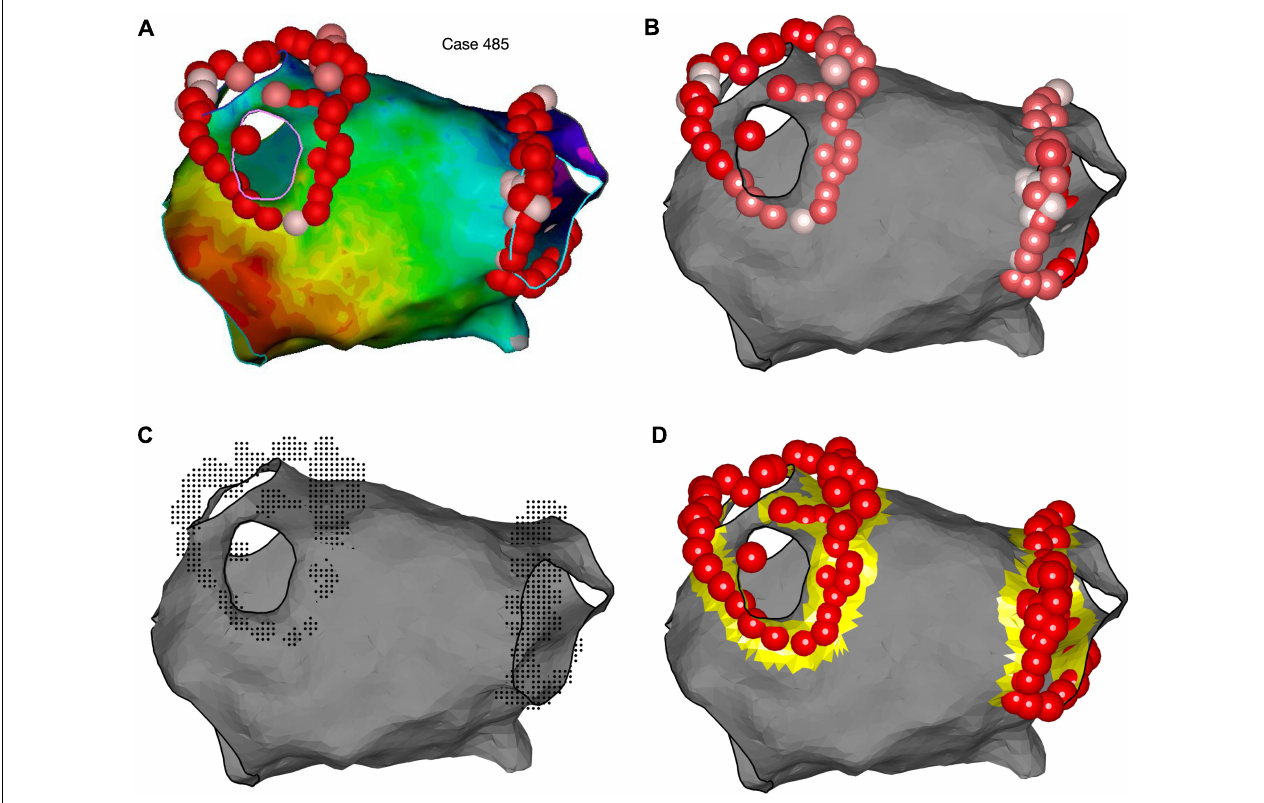
FIGURE 13 | Representation of ablation points and quantification of ablation area using OpenEP. (A) Ablation lesion representation in the Carto electroanatomic mapping platform. (B) Ablation lesion representation using OpenEP. Ablation lesions are colored according to the Ablation Index (low = white; high = red). OpenEP function call: plotVisitags(userdata, 'color', visitag.tag.index.value) . (C) Specifically for the Carto electroanatomic mapping platform the “grid” of ablation positions is also exposed together with all ablation-related data (impedance, time, temperature, and contact force). OpenEP function call: plotVisitags(userdata, 'plot', 'grid') . (D) Ablation area can be calculated with the OpenEP function call: ablArea = getAblationArea (userdata) . Ablation area can be added to an existing plot using the OpenEP function: plotAblationArea(userdata)